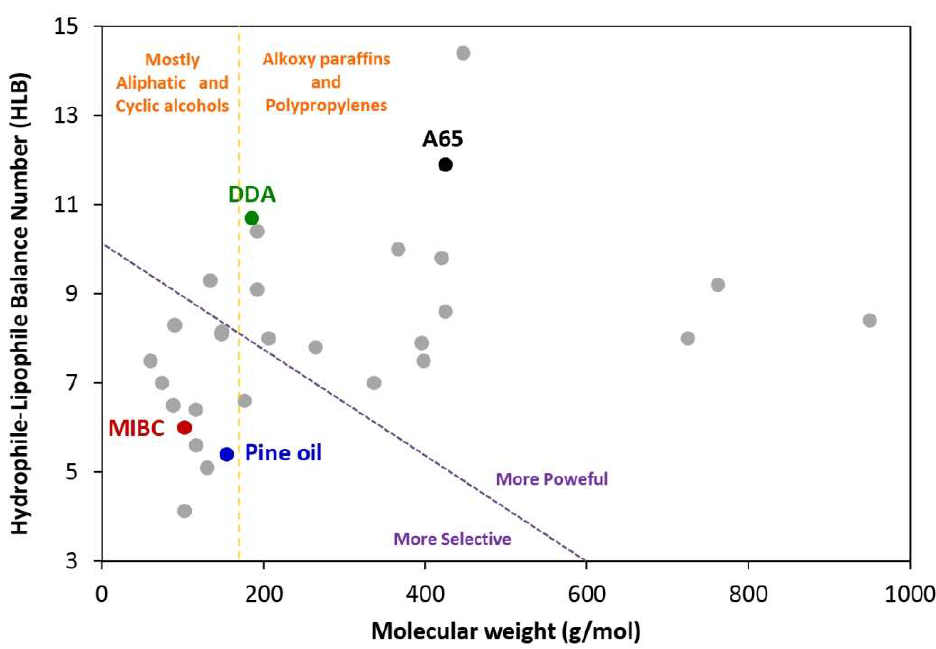
Figure 8. Classification of surfactants based on HLB–molecular weight diagram (drawn for HLB values < 15 and MW < 1000 g/mol; Grey dots correspond to other frothing surfactants reported in the literature [126,184].